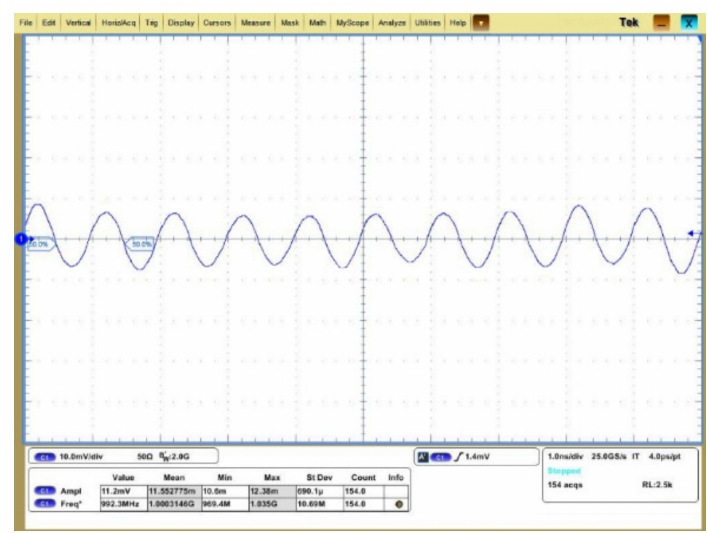
Figure 15. 11.2-mV 1-GHz output sinusoid signal at 4.2 K.